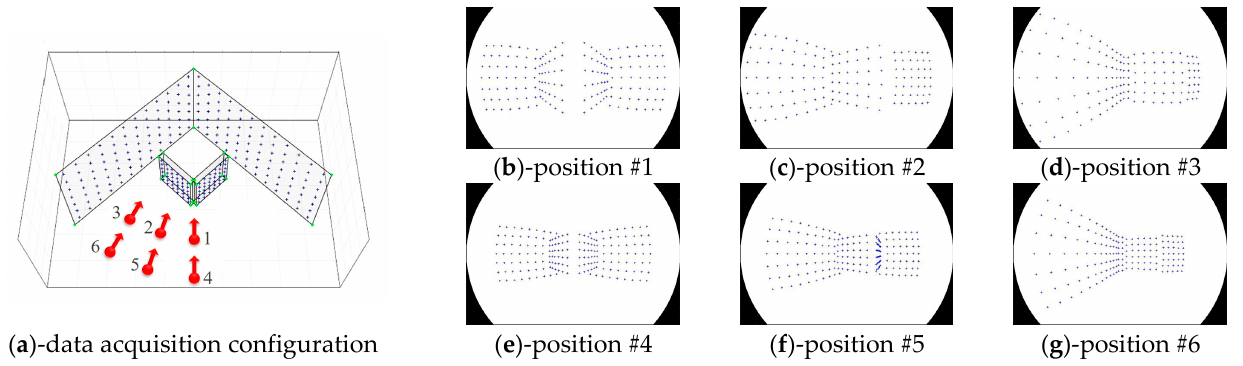
Figure 8. Distributions of image points in case of AV-type test-bed (equidistant).